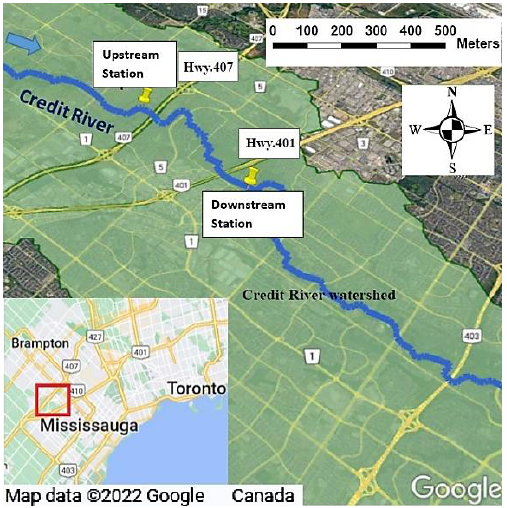
Figure 6. Case study site on Highways 407 and 401 at Credit River.